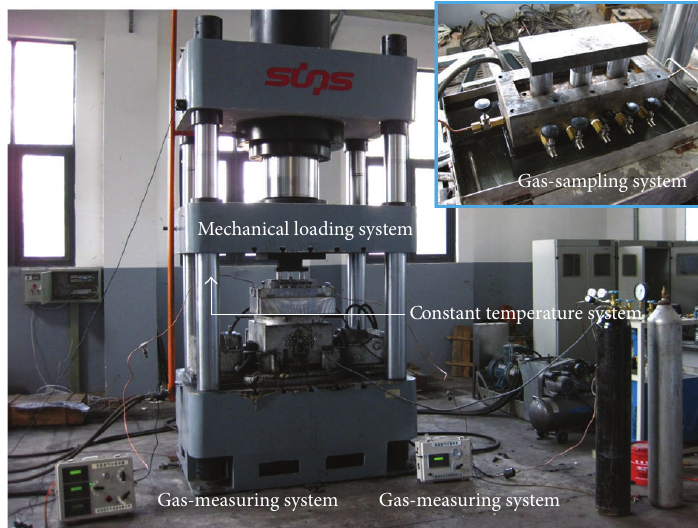
Figure 3: Schematic of experimental apparatus for displacement experiments.